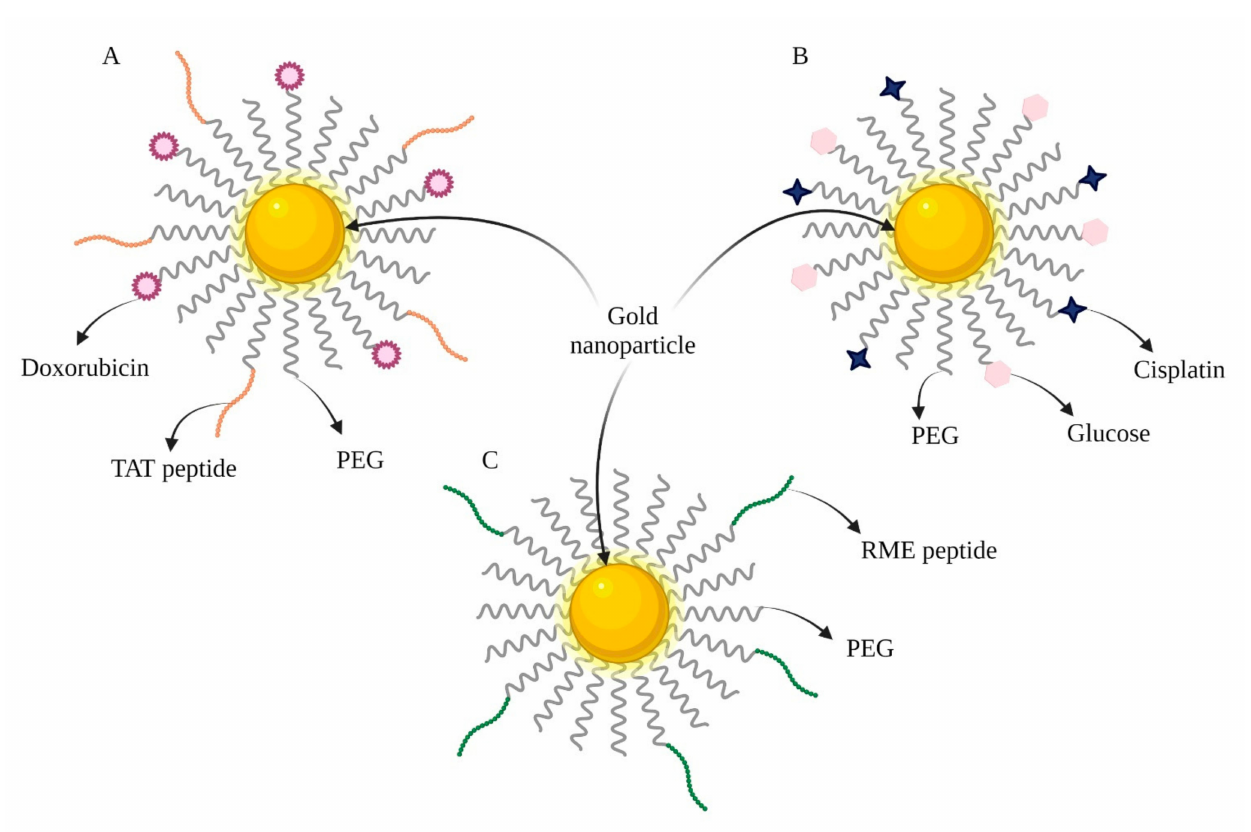
Figure 2. Combined nanoparticles: ( A ) Au-TAT-DOX-PEG; ( B ) CG- Au NPs; ( C ) Au NPs-RME (created using BioRender.com, access date: 6 May 2022).